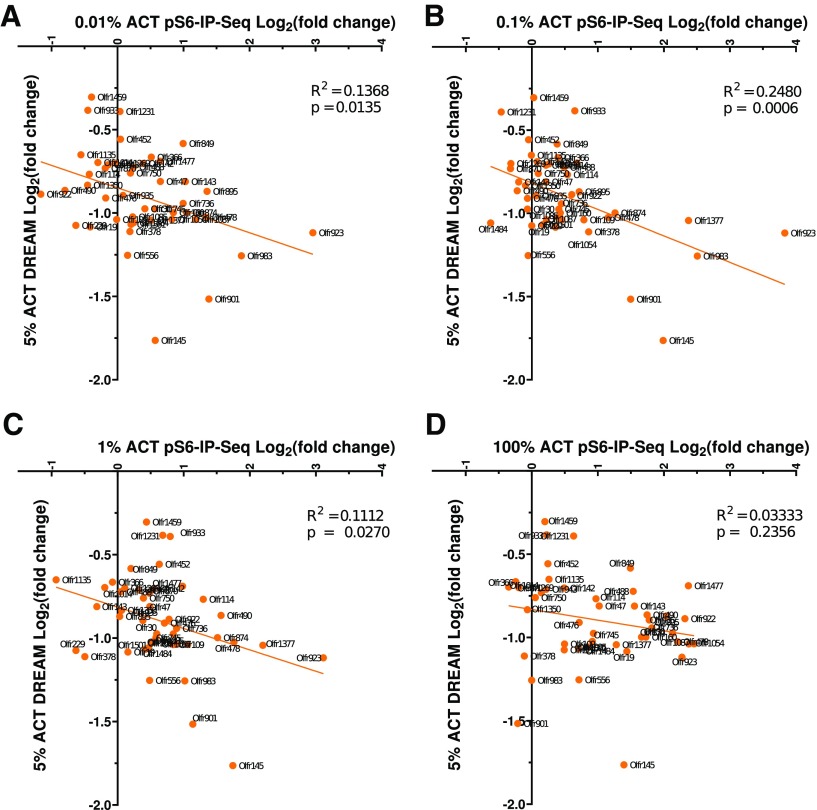
Correlation of pS6 induction and downregulation of mRNA expression. Individual ORs pS6-IP-Seq fold changes based on 0.01% (A), 0.1% (B), 1% (C), and 100% (D) ACT are compared with the DREAM 5% ACT fold changes based on 0.01%, 0.1%, 1%, and 100% ACT are compared with the DREAM 5% ACT fold changes (sequence data realigned using the updated UTRs with coding exons annotation and STAR bioinformatics pipeline). All 45 of the previously reported 5% ACT DREAM responsive ORs were shown. R2 and p values are based on linear regression. See Extended Data Figure 5-1 for the pS6-IP-Seq response of specific DREAM ACT ORs. See Extended Data Figures 5-2, 5-3 DREAM differential expression data supporting this figure.